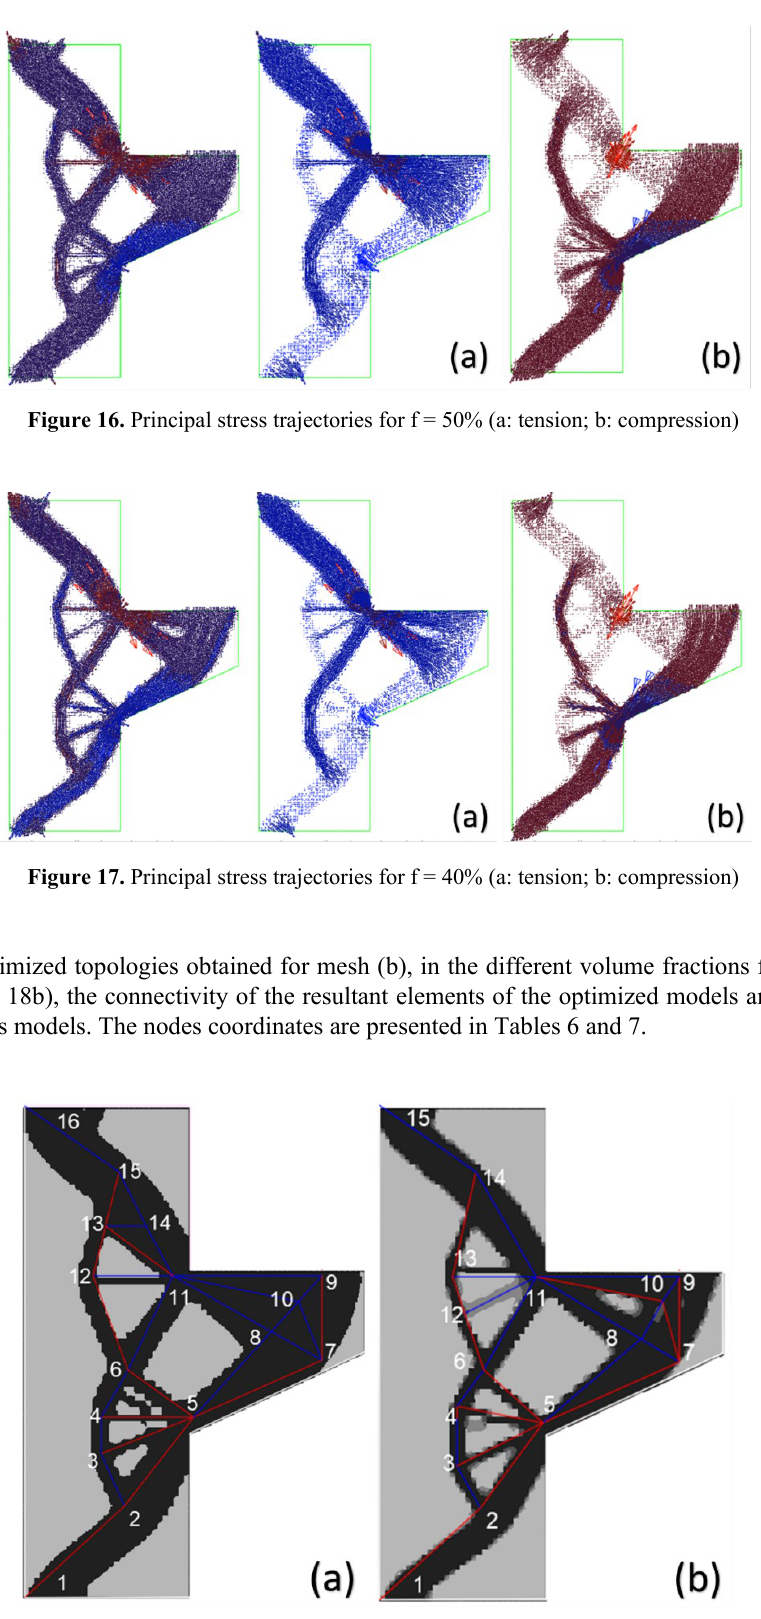
Figure 18. Suggested truss models for the trapezoidal corbel a) f = 50%; b) f =